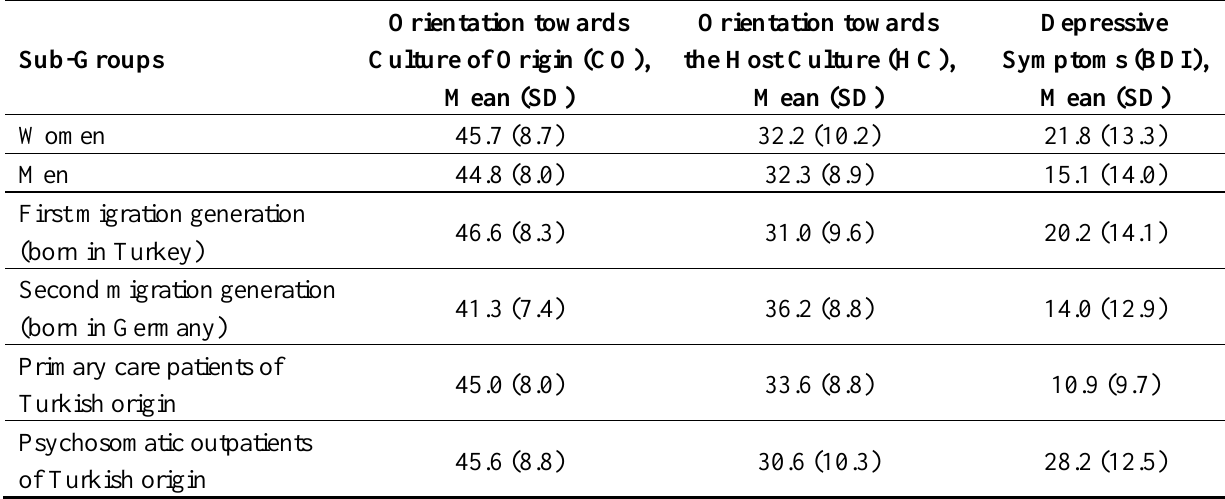
Table 3. The degree of orientation towards culture of origin (CO) and towards the host culture (HC), as well as depression levels according to gender, migrant generation, and